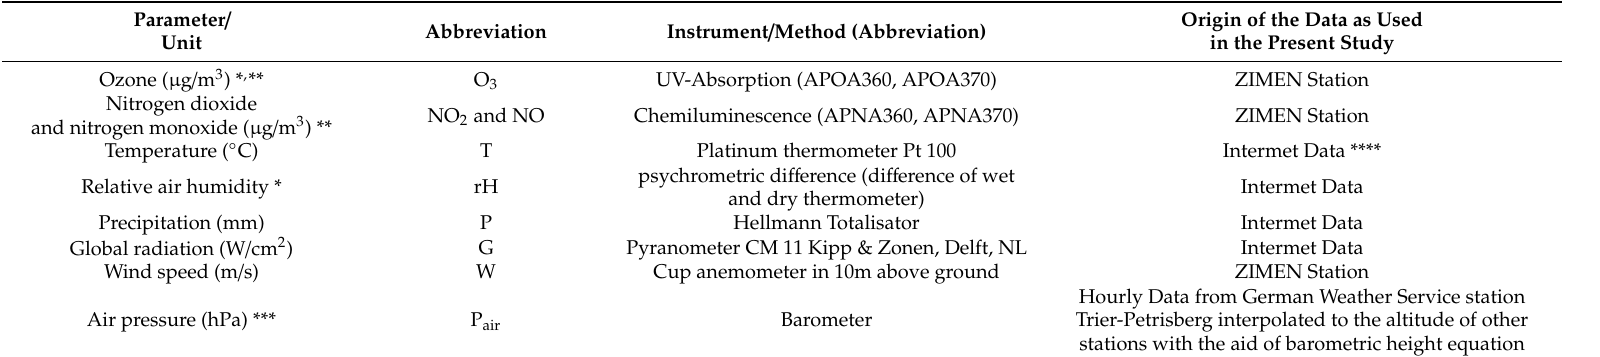
Table 2. Parameters, instruments and methods used to measure pollutant and meteorological parameters at ZIMEN stations (www.luft-rlp.de) and origin of the data used in the present study.